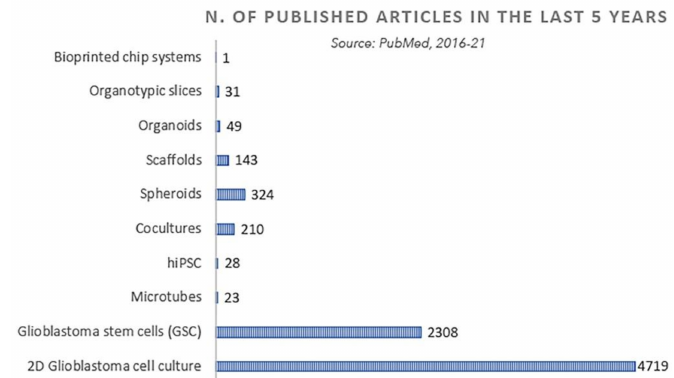
Figure 1. Number of published papers using or referring to the GBM experimental models reviewed above. Source: